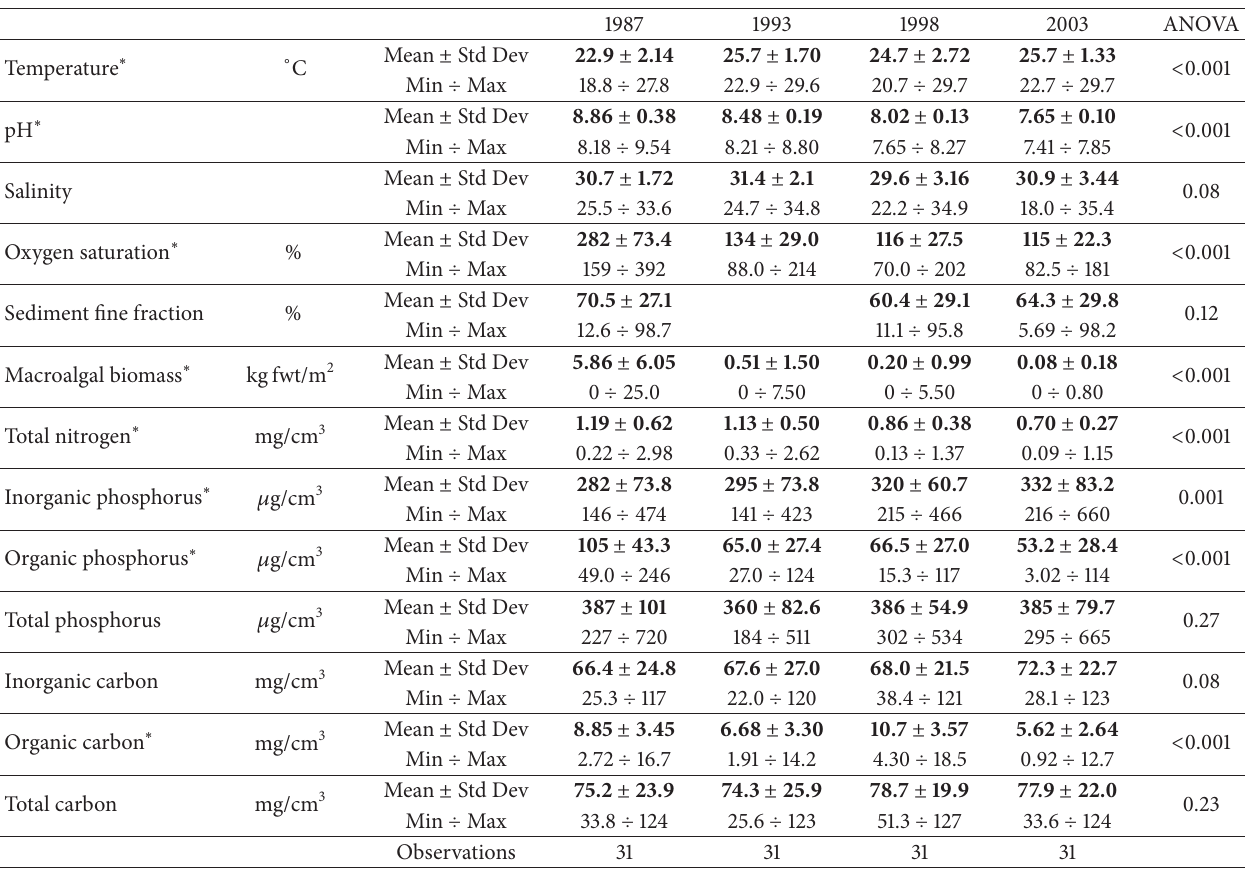
Table 2: Abiotic and biotic data measured in central part of Venice Lagoon in 1987, 1993, 1998, and 2003 surveys (mean ± standard deviation (Std Dev), minimum (Min) and maximum (Max)